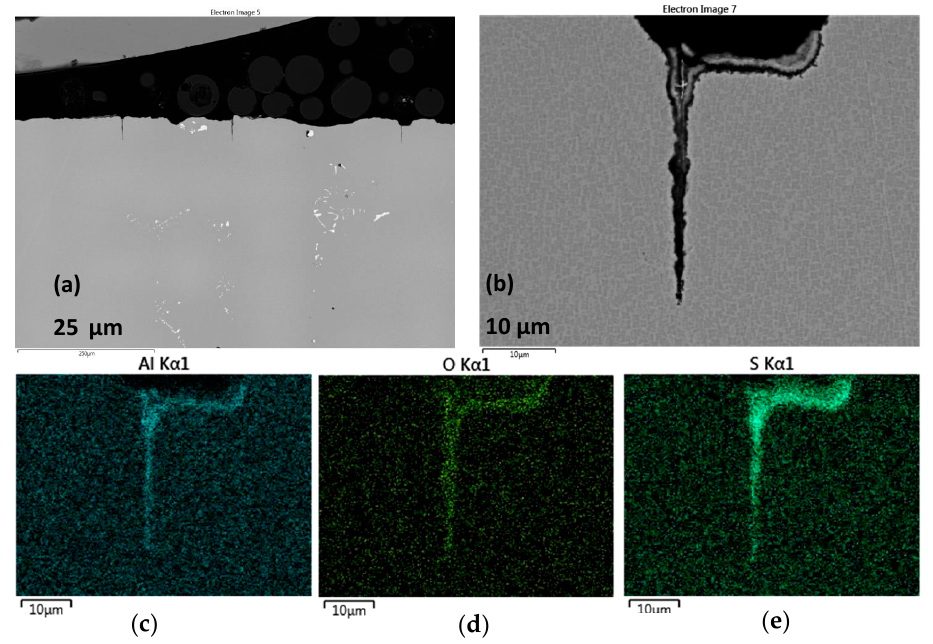
Figure 8. Cross-section of Rene ′ N5 sample after 300 h LTHC at 700 °C showing deep crack-like penetrations (( a , b ) SE images) with Al, O, S concentration (( c – e ) elemental rasters).